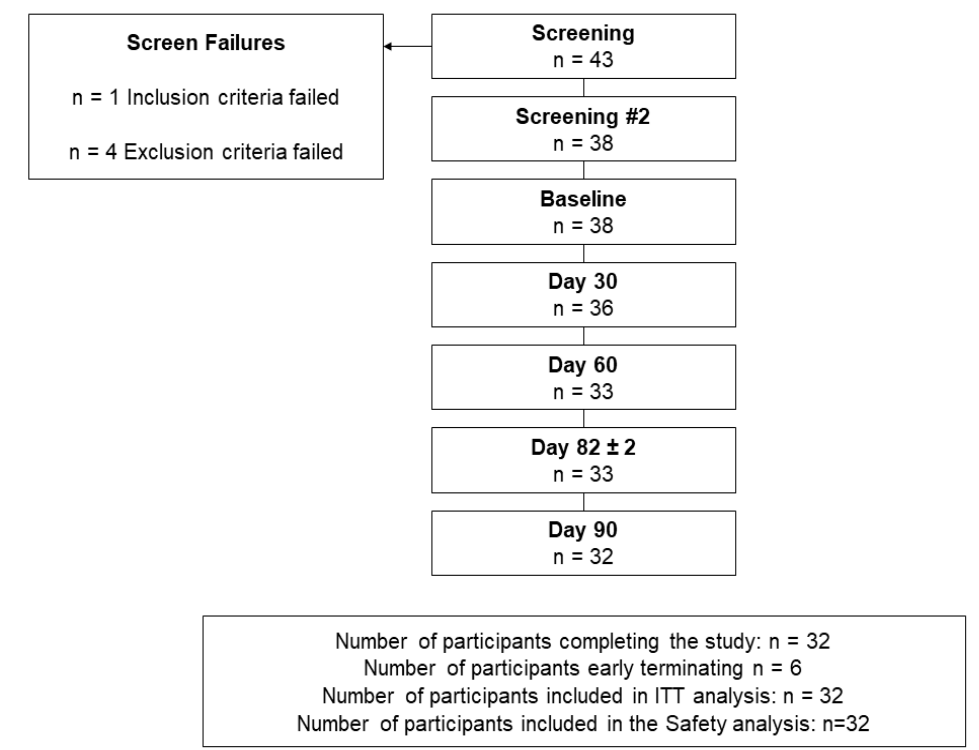
Figure 1. Disposition of participants.